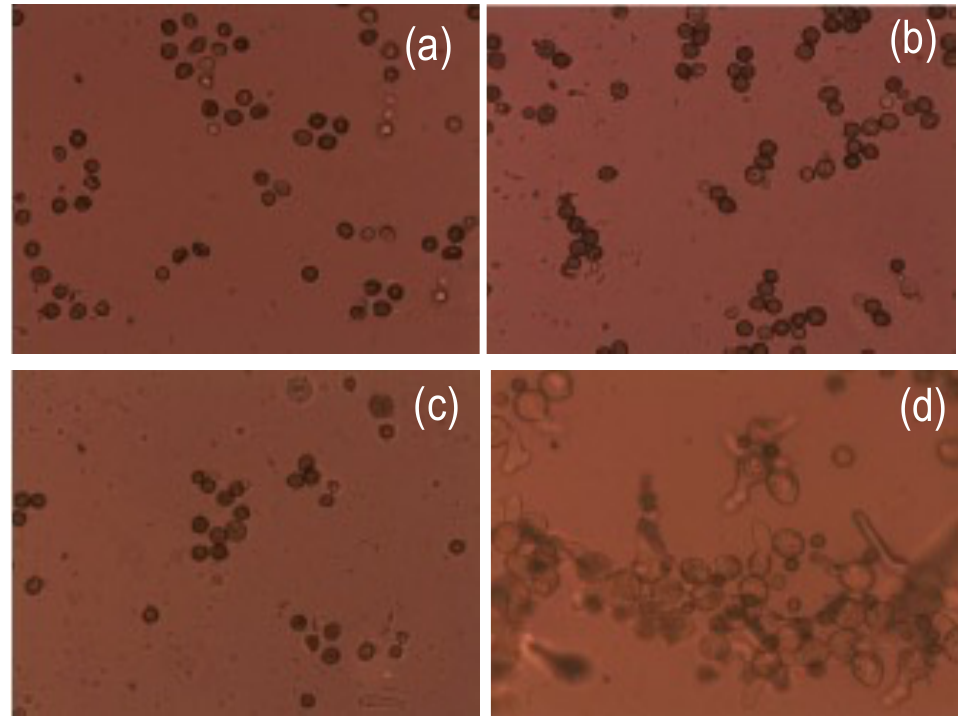
Figure 6. Mycelium of Aspergillus parasiticus grown on chitosan (CH) and squid gelatin hydrolysates (SGH) films. At 12 h after incubation at 25 °C, at 40×: ( a ) 100 CH/0 SGH, ( b ) 90 CH/10 SGH, ( c ) 80 CH/20 SGH, and ( d ) 60 CH/40 SGH.